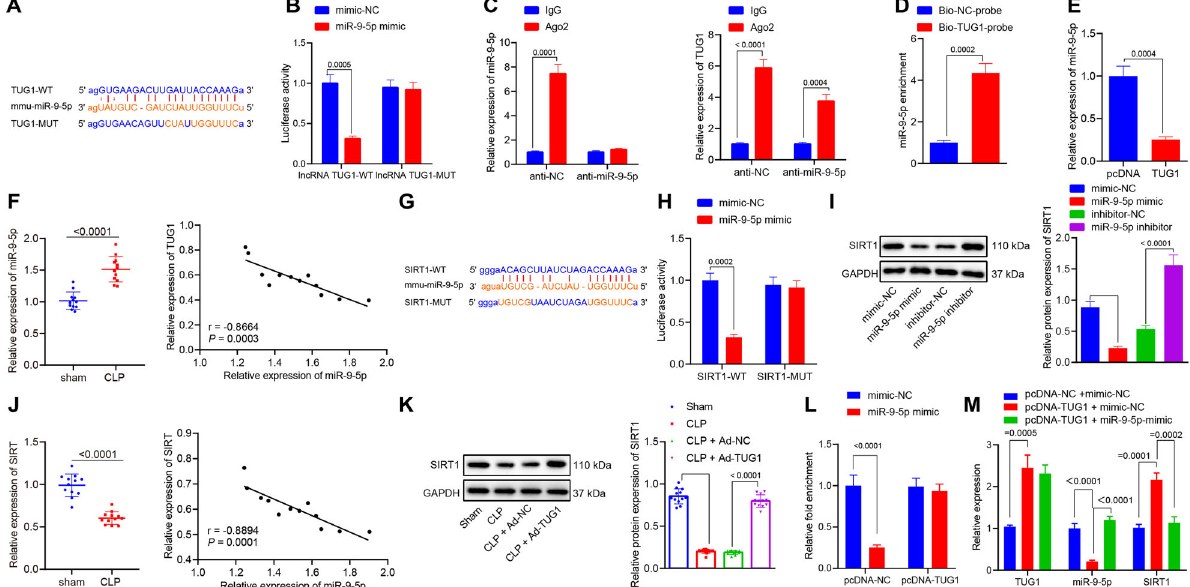
Fig. 4 TUG1 upregulates the expression of SIRT1 by functioning as a ceRNA of miR-9-5p. A Complementary binding sites and mutation sites between TUG1 and miR-9-5p predicted on Starbase website (http://starbase.sysu.edu.cn/). B The luciferase activity of TUG1 -WT and MUT analyzed by dual-luciferase reporter gene assay. C Enrichment of TUG1 and miR-9-5p by anti-Ago2 or anti-IgG analyzed by RIP assay. D TUG1 pull-down pellet containing a large amount of miR-9-5p examined by RNA pull-down assay. E The level of miR-9-5p in macrophages transfected with pcDNA- TUG1 or pcDNA-NC determined by RT-qPCR. F The relative expression of miR-9-5p in sham- or CLP-operated mice evaluated by RT-qPCR (left), and Pearson ’ s correlation analysis of the levels of TUG1 and miR-9-5p in mouse lung tissues (right, n = 12). G SIRT1 as a downstream target of miR-9-5p predicted on Starbase, showing the putative SIRT1 binding site of miR-9-5p (SIRT1-WT) and the designed mutant sequence (SIRT1-MUT). H The luciferase activity examined by the dual-luciferase reporter gene 48 h after cotransfection with miR-9-5p mimics and SIRT1-WT or SIRT1-MUT. I The protein expression of SIRT1 in in macrophages transfected with miR-9-5p mimic, miR-9-5p inhibitor, or their NCs determined by western blot analysis. J The relative expression of SIRT1 in sham- or CLP-operated mice assessed by RT-qPCR (left), and the Pearson ’ s correlation analysis of the levels of SIRT1 and miR-9-5p in the mouse lung tissues (right, n = 12). K Western blot analysis for determination of protein expression of SIRT1 in mouse lung tissues. L The binding of miR-9-5p and SIRT1 after pcDNA- TUG1 treatment identi fi ed by dual-luciferase reporter gene assay. M TUG1 , miR-9-5p, and SIRT1 expression after treatment with pcDNA- TUG1 and miR-9-5p mimic were determined by RT-qPCR. Measurement data were expressed as mean ± standard deviation. Data between two groups were compared using unpaired t -test. One-way ANOVA was adopted for comparison between multiple groups followed by Tukey ’ s post hoc test. Cell experiments were conducted three times independently. * p < 0.05 vs. mimic NC, IgG, Bio-NC-probe, pcDNA, or sham group; # p < 0.05 vs. anti-NC, inhibitor-NC, CLP + Ad-NC, or pcDNA- TUG1 + mimic NC